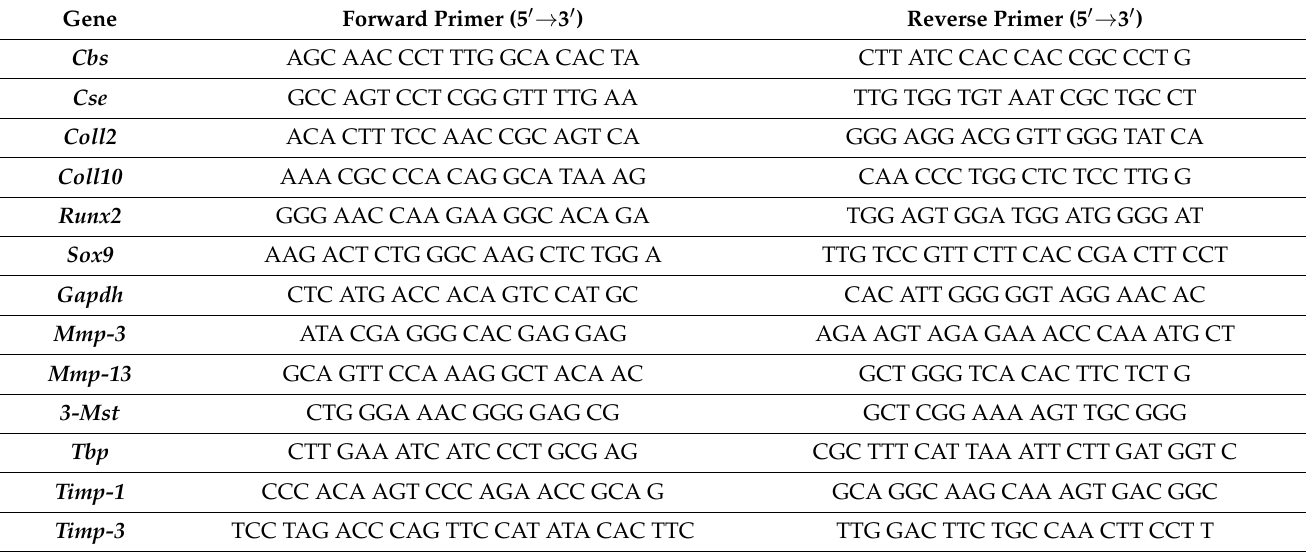
Table 1. Murine gene specific primers for